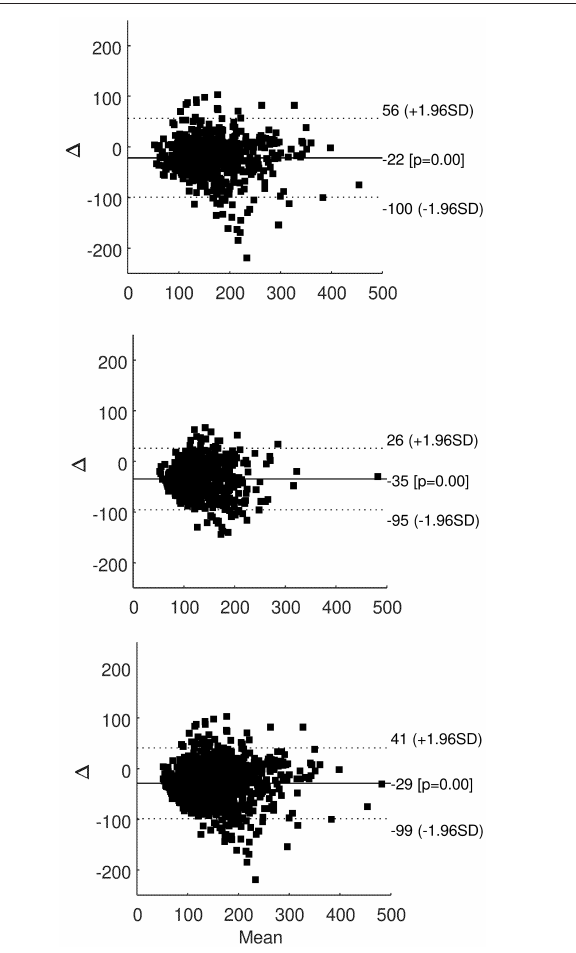
FIGURE 2 | Bland-Altman plot of SMBG and FGM readings in all patients grouped, for readings during hemodialysis sessions (upper panel), during interdialytic periods (only T2DM patients; intermediate panel), and for all readings grouped (lower panel); solid line is average difference (with p -value compared to zero difference), dotted lines are ± 1.96 standard deviation ( SD ) of the